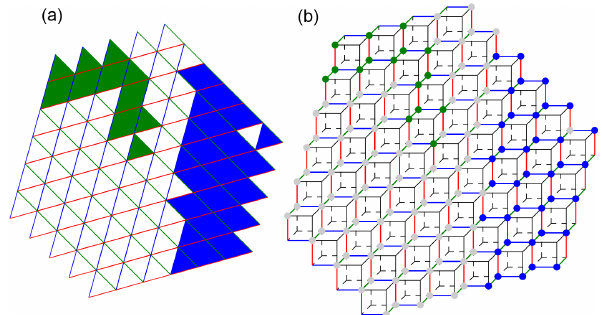
Figure 9. Illustration of the result of connected component labeling for 2-D data and vertex connectivity. In (a) , connected components are formed by cells with the same face color. The colors of the cell edges that form the hyperplanes of the cubulation are also shown. Panel (b) illustrates the same data on the cubulation. Triangles in (a) correspond to vertices in (b) . A set of triangles on the triangular grid is vertex connected if any two of the vertices on the cubical grid can be connected by a sequence of vertices where subsequent ones are in a common two-dimensional face (i.e., a square) of a cube.